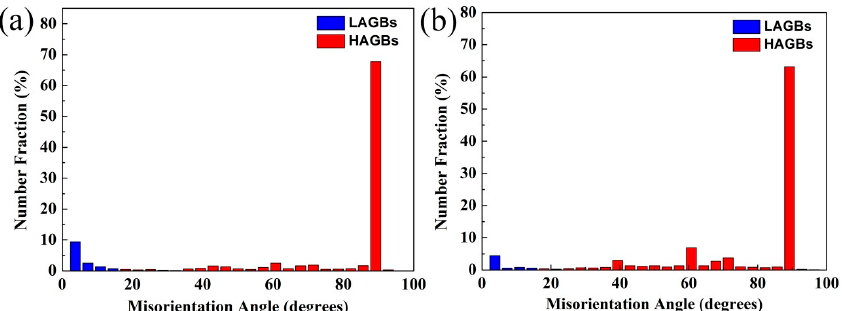
Figure 5. Misorientation angle distributions of the γ phase in the hot-deformed Ti-43Al-9V-0.2Y alloys: ( a ) As-forged; ( b ) Hot-rolled.